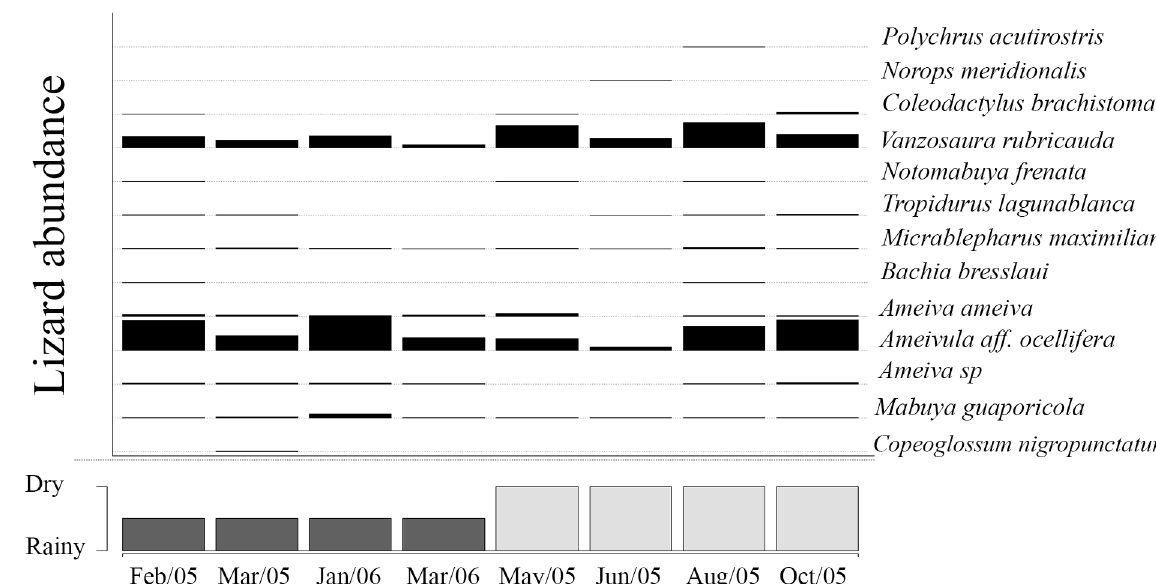
Figure 3. Distribution of lizard species in relation to season in the Nhumirim Ranch, Pantanal, Brazil. Bar thickness is proportional to lizard abundance (full bar ~ 90 individuals). Sampling in the rainy season (dark-gray bars); Sampling in the dry season (light-gray